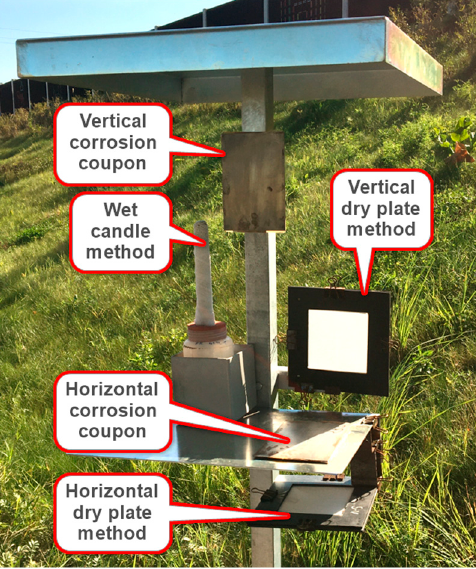
Figure 3. Typical stand for experimental measurement of deposition chloride ions.